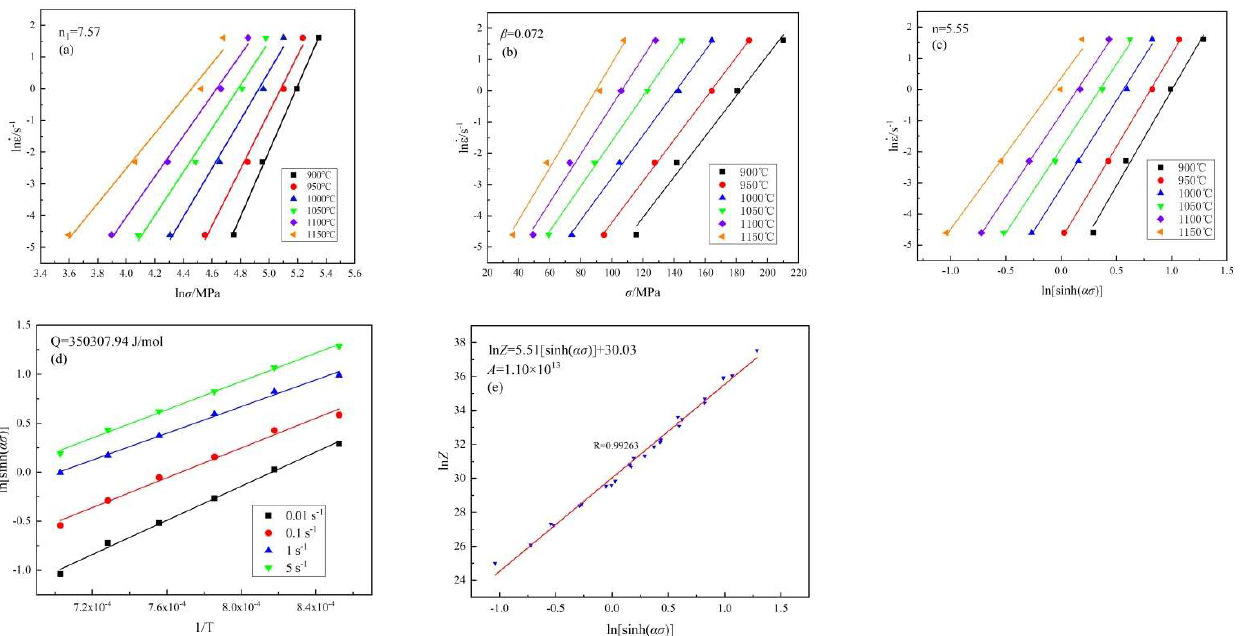
. . . ε − ln σ ; ( b ) ln ε − σ ; ( c ) ln ε − ln [ sinh ( ασ )] ; ( d ) ln [ sinh ( ασ )] − 1/ T ;